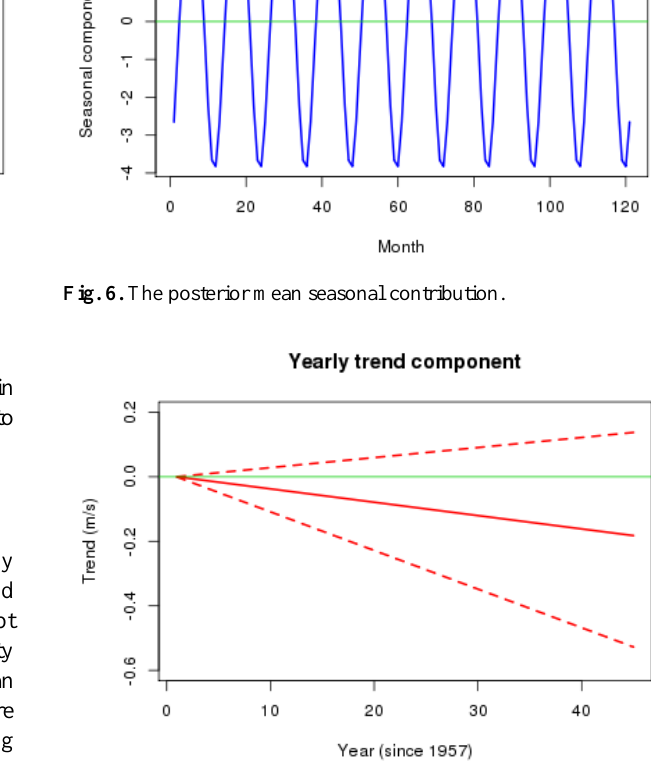
Fig. 8. Results from the model without trend; the mean spatial field